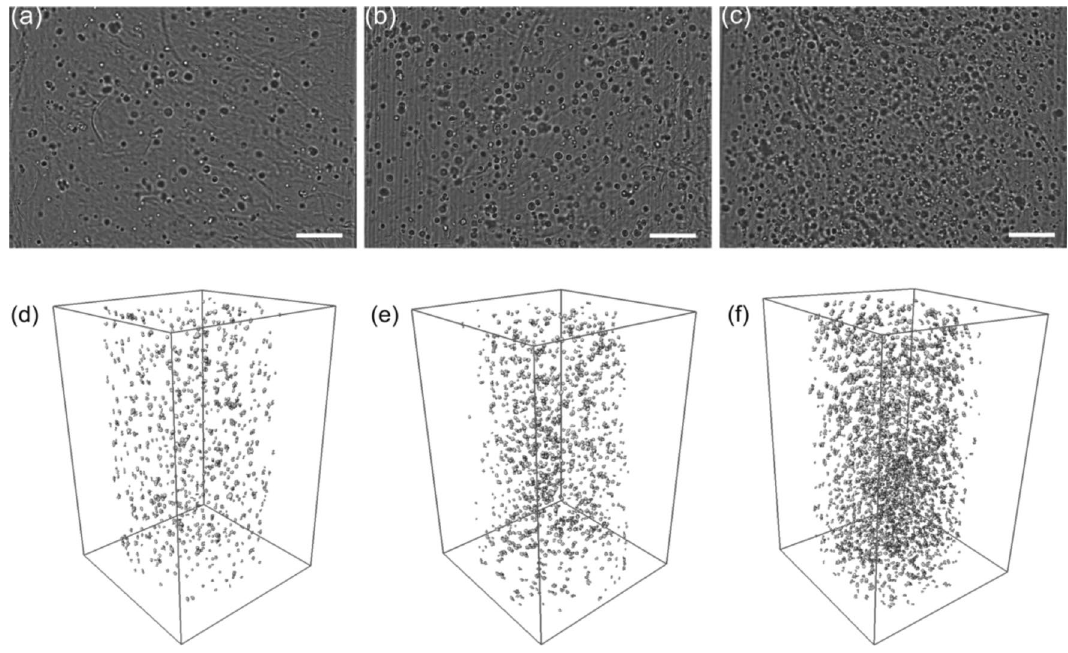
Figure 5. Bright-field OPT projection images of human lung fibroblast (WI-38) cells in 3D GG hydrogel after 7 days culturing with initial cell seeding density of ( a ) 300,000 cells/mL, ( b ) 500,000 cells/mL, and ( c ) 1,000,000 cells/mL; ( d – f ) 3D reconstructed images of cells in ( a – c )), respectively. The scale bar in the images represents 200 µm. Initial seeded cell density (number of cells/mL) Quantified cell density (average number of cells/mL) 169,007 Fraction of quantified density with respect to the initial 56% Table 1. The measured initial density of cells and the quantified cell density after culturing of the cells for 7 days in GG hydrogel. T-test was applied to compare between the initial and quantified cell density. n = 3, (* P < 0.05; ** P < 0.01; *** P < 0.001).